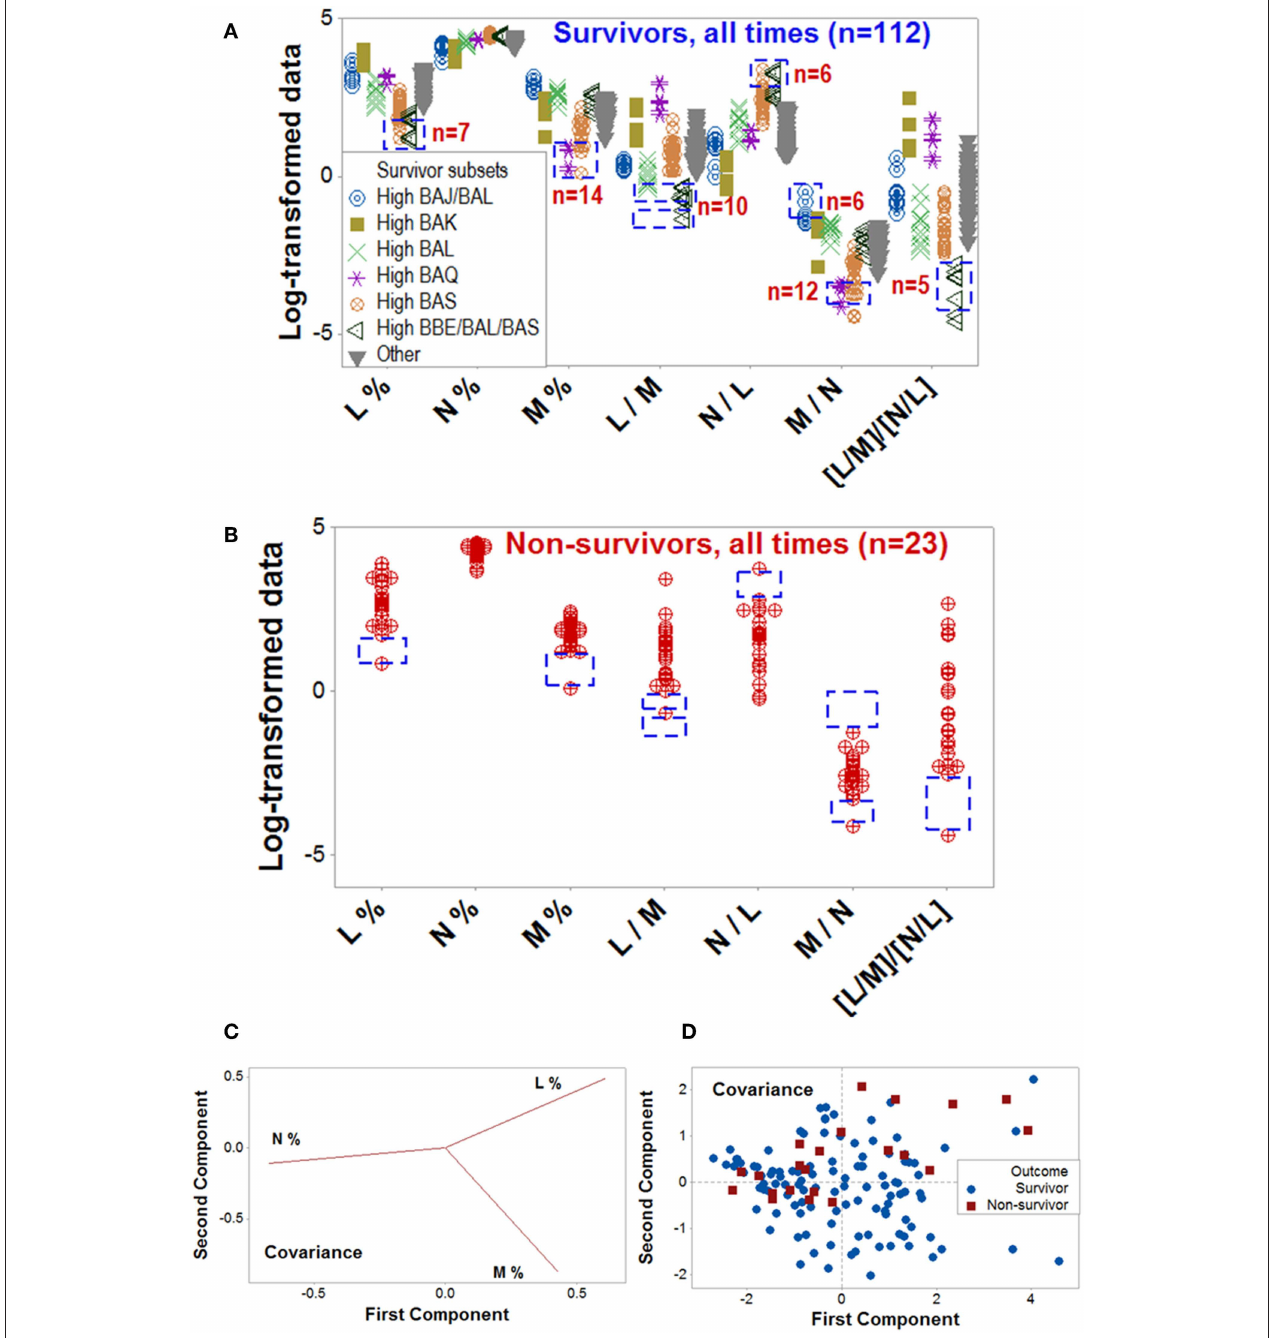
FIGURE 7 | Validation of data patterns and assessment of pathogenesis. The data ranges of some biologically interpretable variables or relationships were explored with data collected at all time points, from all patients ( n = 135). Supplementary Video 1 shows a temporal assessment of pathogenesis. Rectangles show some data ranges contributed by survivors (A) , which were not displayed by non-survivors (B) . While the number of survivors ( n = 32) was 4 times higher than non-survivors ( n = 8), some differences exceeded the 4:1 ratio, e.g., survivors reported 10 observations within a monocyte percentage interval within which no non-survivor contributed any data point (rectangles, A,B ). Unlike the PRM, PCA did not discriminate hantavirus-related outcomes: while the loading plots displayed distinct differences between the three input variables (C) , such differences did not result in pattern recognition (D) . Because the PCA conducted with the covariance alternative yielded similar results, it is not shown. Initials are defined in Figure 1